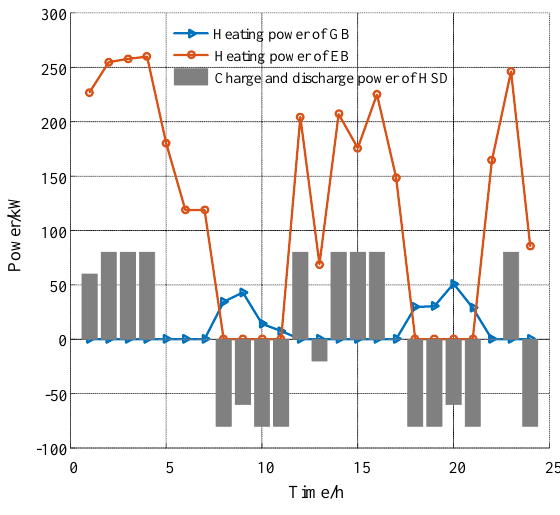
Figure 6. PIES optimal heating plan.